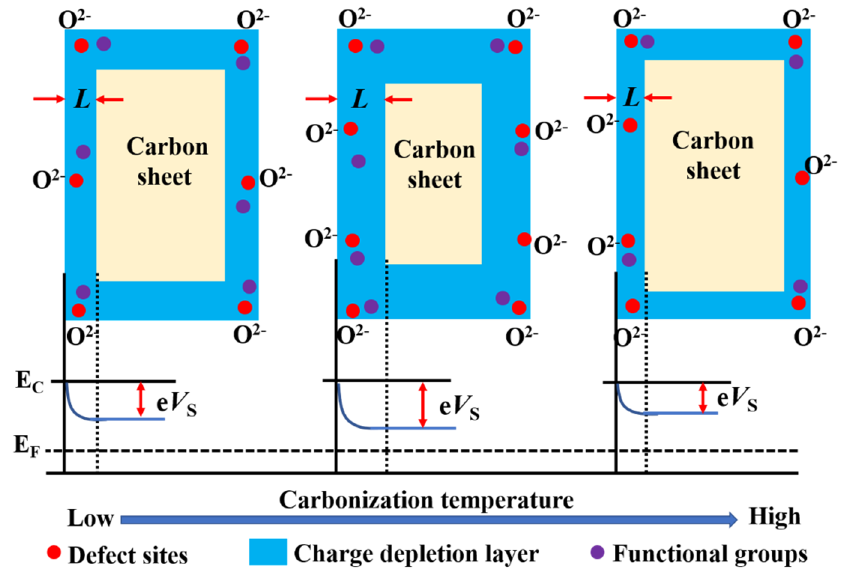
Figure 8. Possible sensing mechanisms of the 6 − 3H sample.